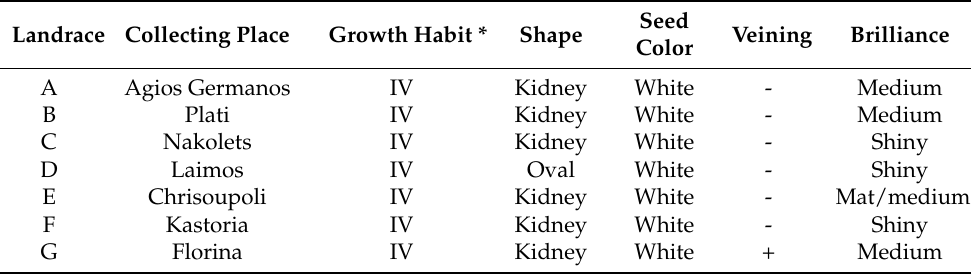
Table 1. Collection place, growth habit, seed shape, coat veining, and brilliance of the seven dry bean landraces.